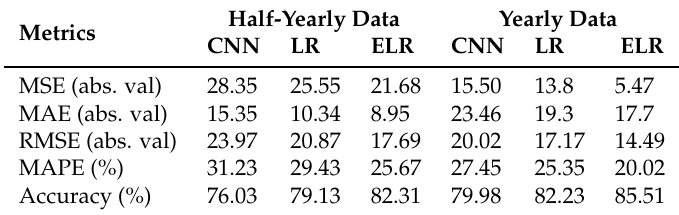
Table 21. Load performance metrics comparison for one month using the UCI Dataset.